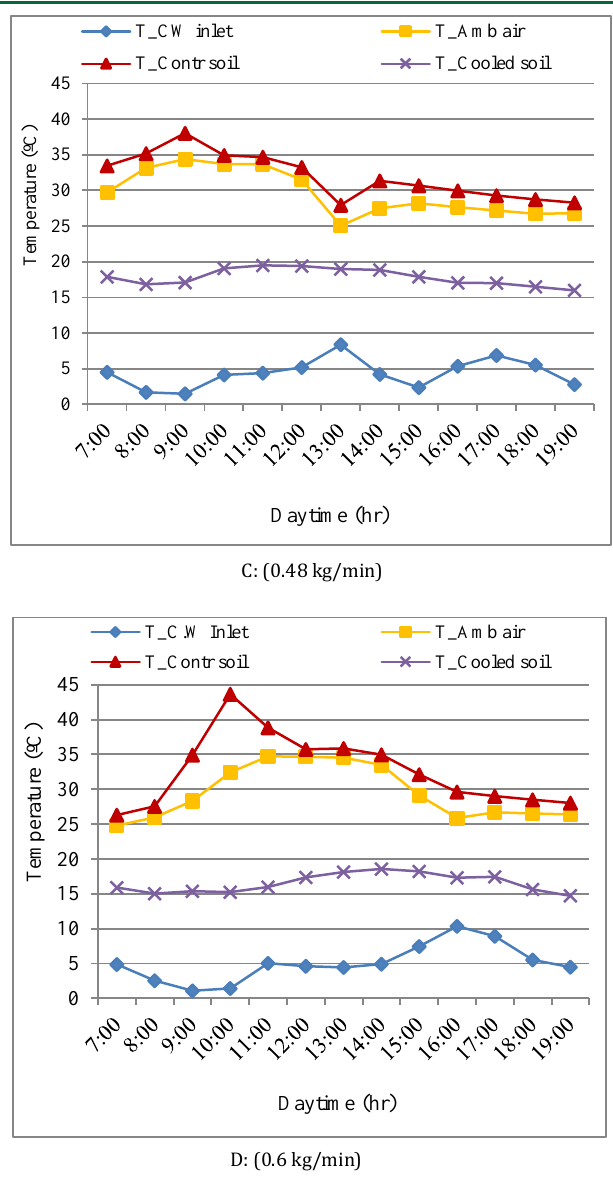
Figure 10: (A-D): Experimental soil temperature profiles Chilled water application was observed to have significant effects on soil